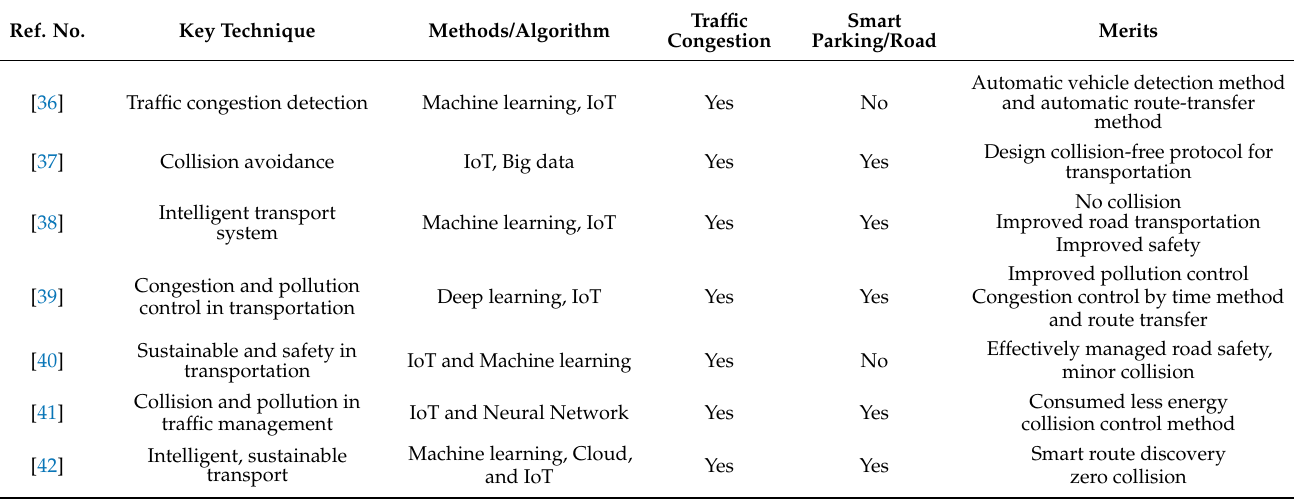
Table 1. Review of various research in IoT and ML-based intelligent transport systems. Ref.